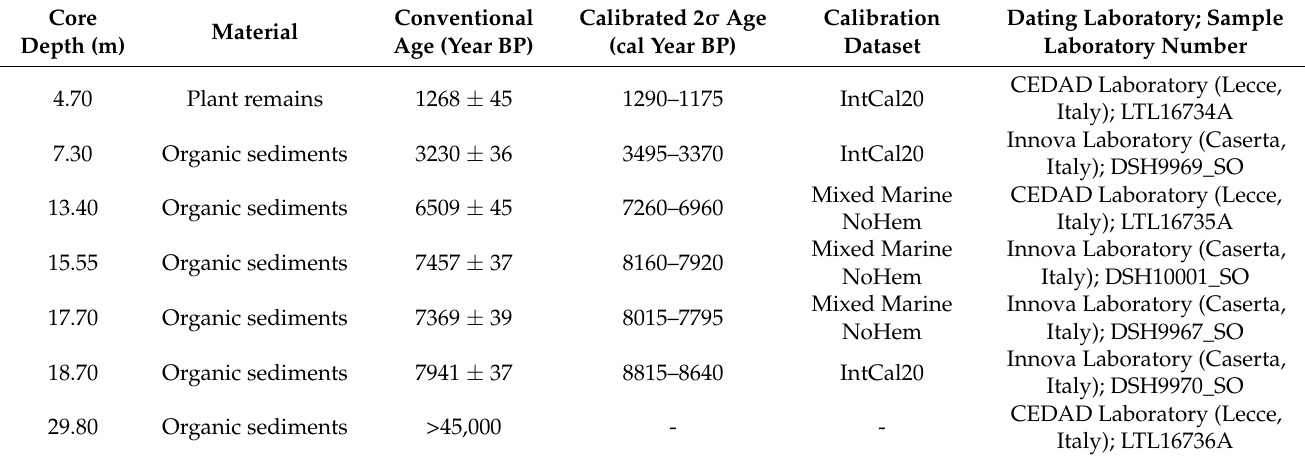
Table 1. Radiocarbon ages from core SP (see Figure 2 for